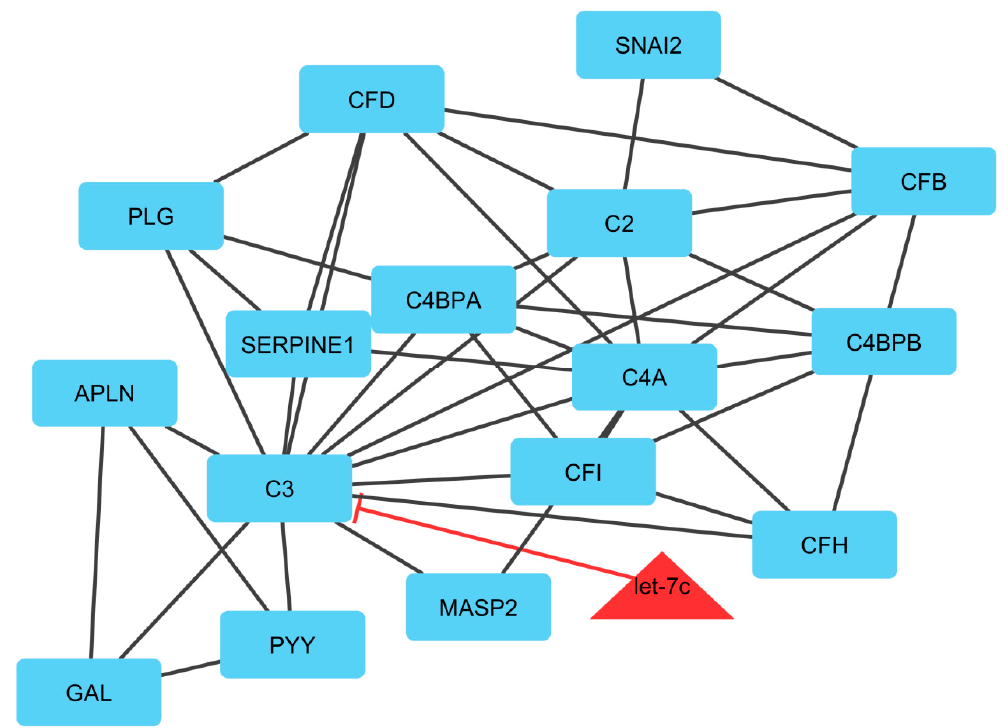
Figure 6. Module 3: 16 mRNAs/genes and 1 miRNA in an interacted network were identified. In this network, the quadrilateral nodes represent mRNAs/genes and triangle nodes represent miRNAs. Edges indicate the interactions; black edges represent mRNA–mRNA interactions and red edges represent miRNA–mRNA interactions.